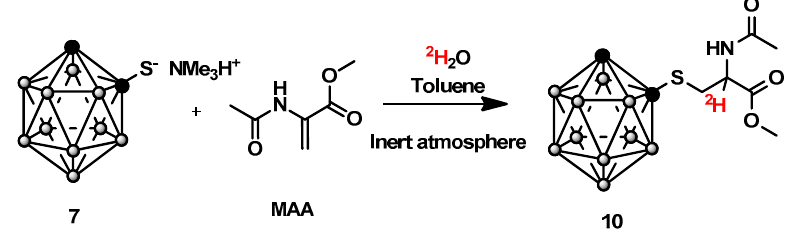
Figure 5. The best root-mean-square overlap for non-hydrogen atoms between crystal (solid lines) and ONIOM-modelled (dashed lines) conformations of 8